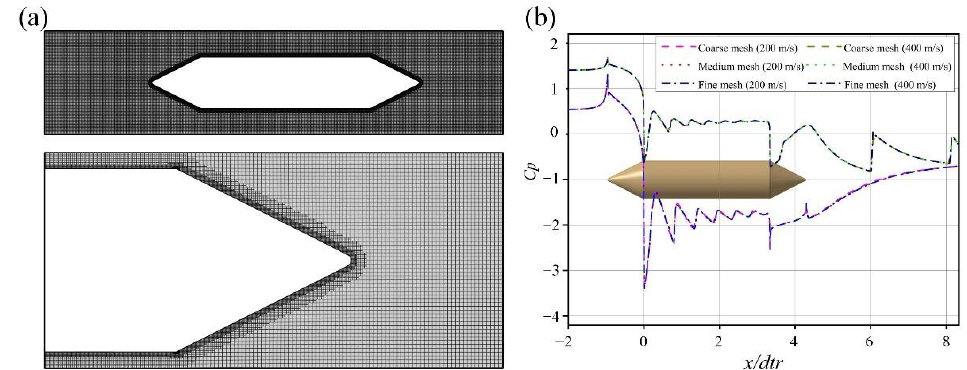
Figure 2. ( a ) Grids around the pod train, ( b ) the distribution of pressure coefficient along the axis of the tube and the longitudinal line on the train surface of the three grids. Table 1. Spatial resolution and drag for coarse, medium, and fine grids.